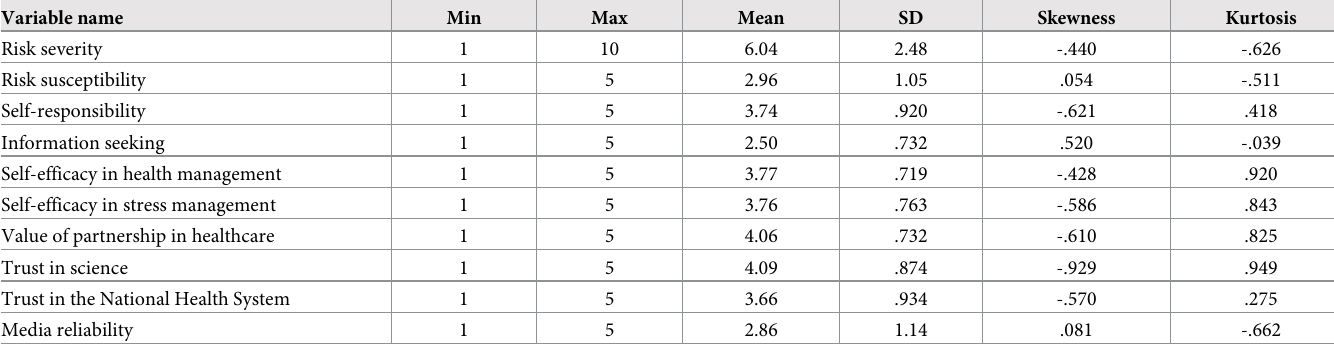
Table 3. Descriptive statistics for